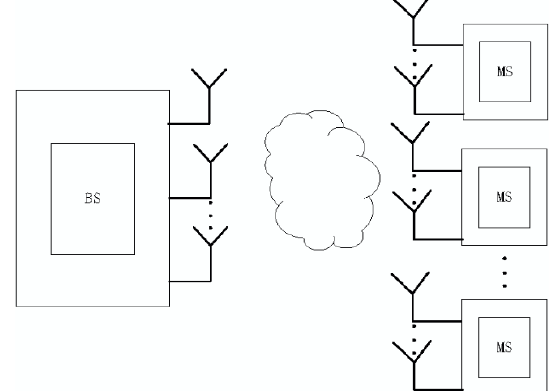
Fig. 2. The basic model of MU-MIMO